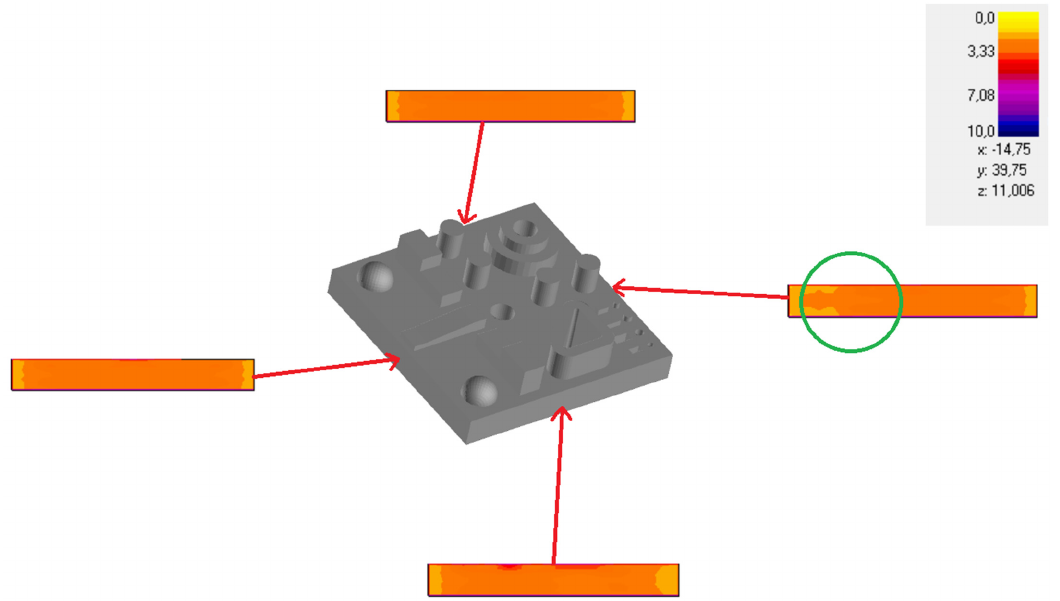
Figure 4. Hot spot (based on CFS time) cut plane on the side faces with the feeder addition location shown with green circle.